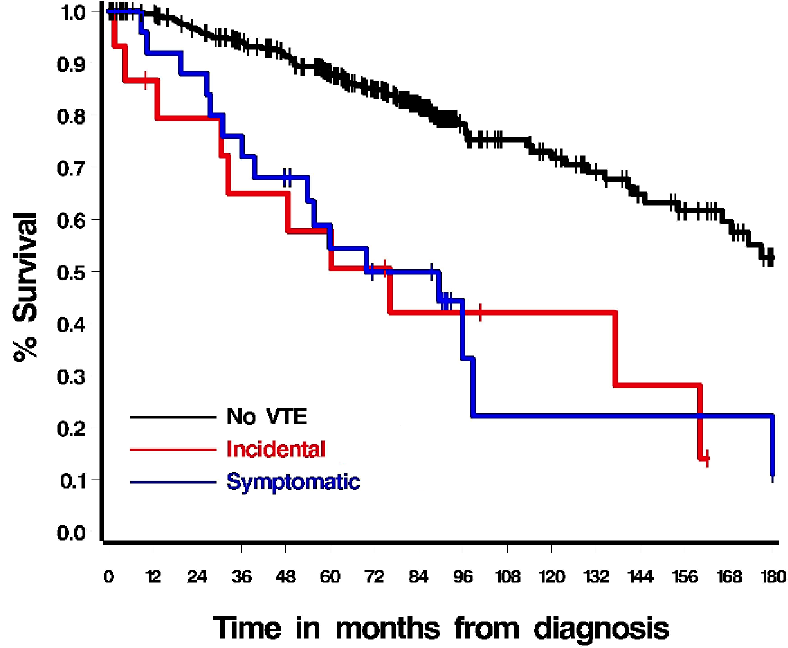
Figure 2. Survival curves depicting survival (in months) for patients with and without venous thromboembolic disease (VTE). Patients with VTE have higher mortality compared to patients without VTE [HR 6.89 (4.29–11.08), p , 0.001]. There was no difference in mortality between patients with symptomatic or incidental VTE (p=0.83). doi:10.1371/journal.pone.0094048.g002 PLOS ONE |